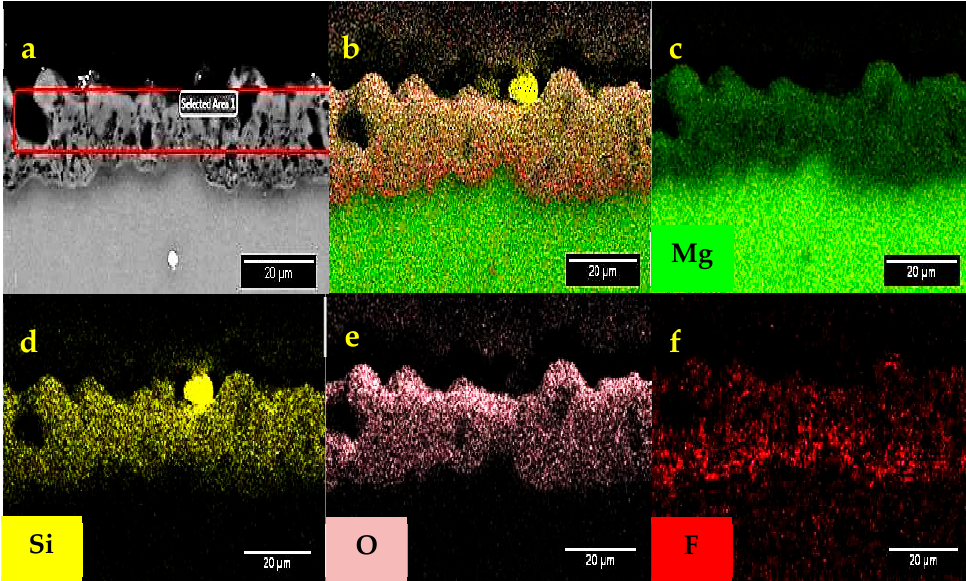
Figure 8. ( a ) Cross-section and elemental maps of B2 produced coating; ( b ) overall colors map, ( c ) map of magnesium, ( d ) map of silicon, ( e ) map of oxygen and ( f ) map of fluoride.